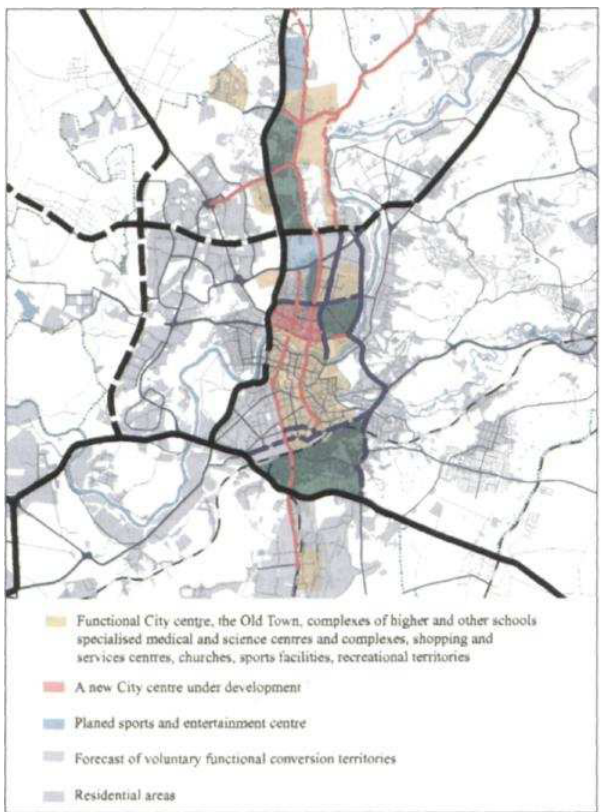
Fig 6. Functional axis of Vilnius and its transport